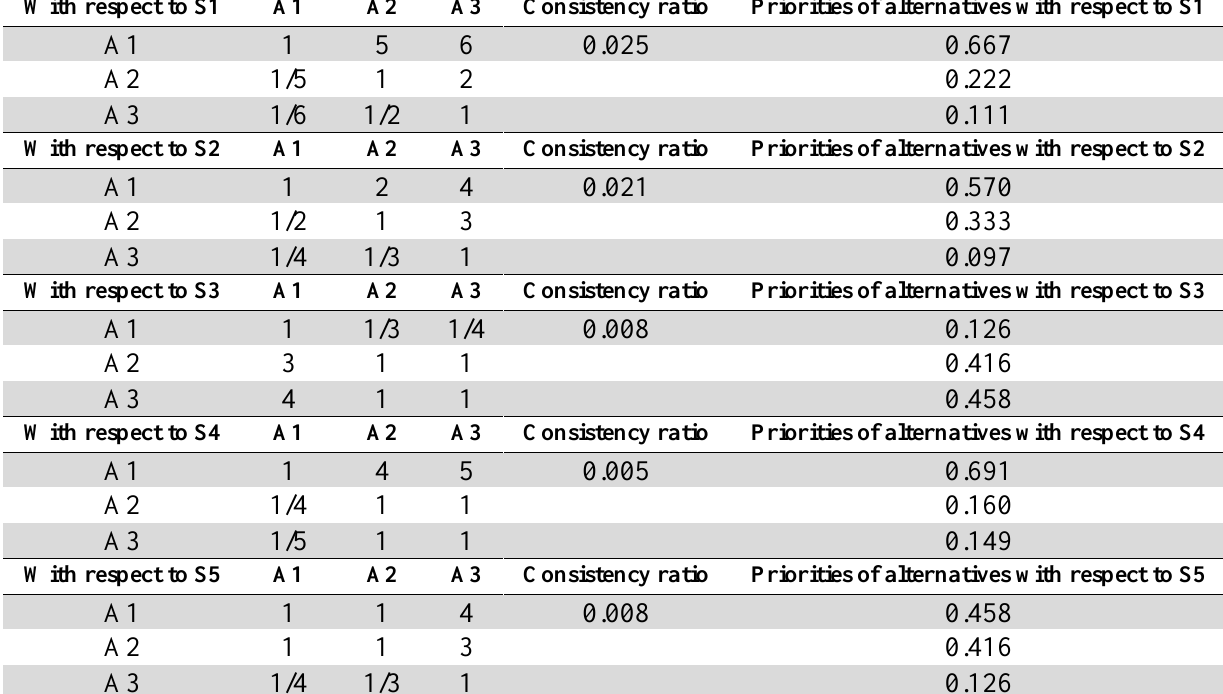
The pair-wise comparisons of alternative strategies with respect to the strength factors With respect to S1 A1 A2 A3 Consistency ratio Priorities of alternatives with respect to S1